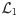
Control experiments introducing malfunction in layer L1.The layout of the figure in each column is similar to that of Fig 3 showing model response to different stimuli. The leftmost column remove L1-harmonic neurons, middle column removes L1-onset neurons and rightmost column contrasts only fast or slow L1 neurons.